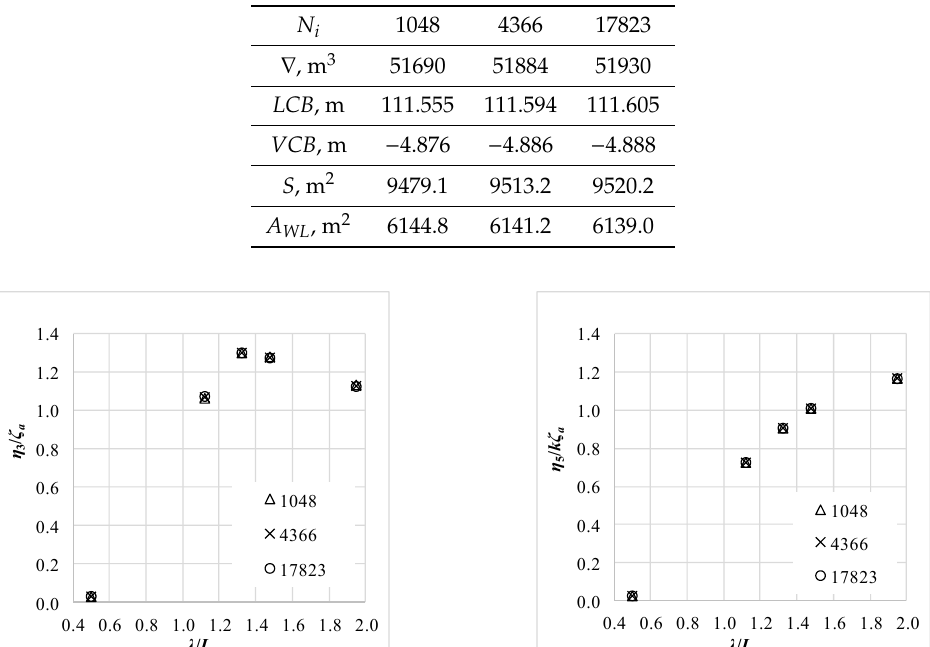
Table 2. Hydrostatic characteristics of KCS obtained using different panel models.